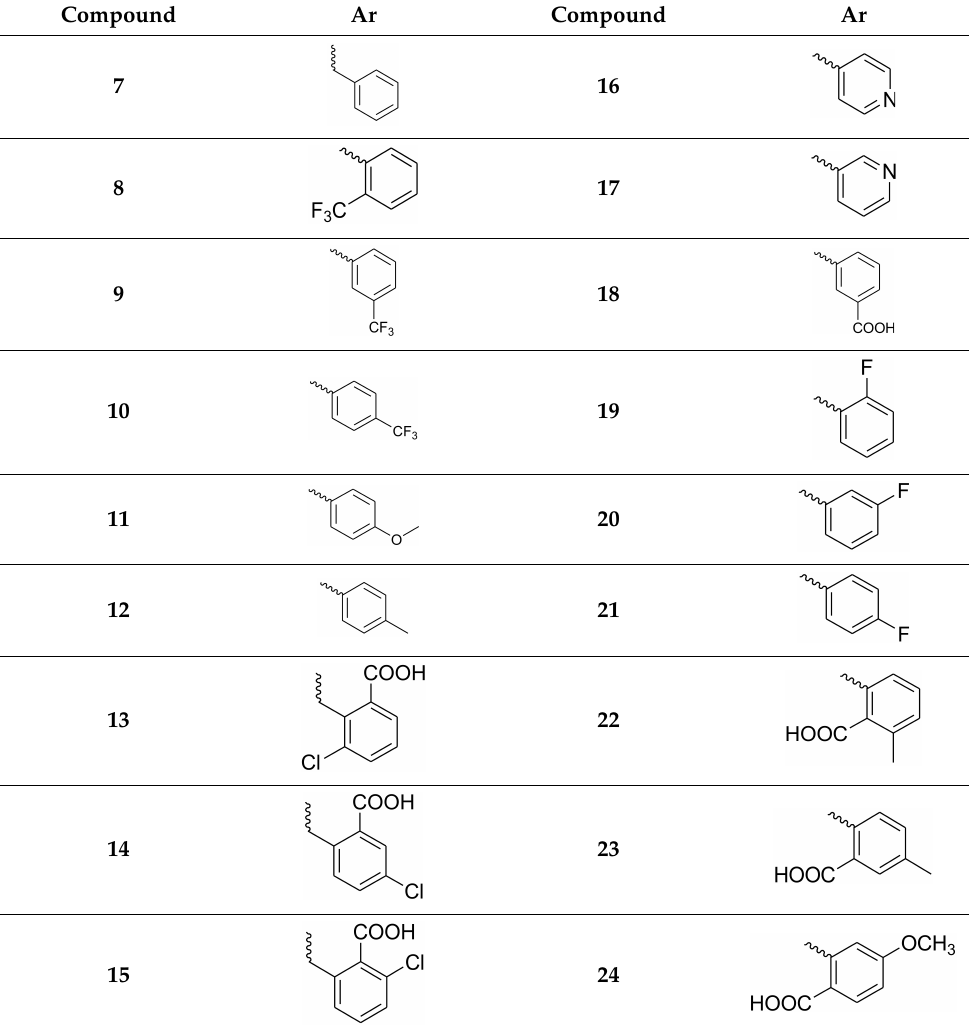
Table 1. Structures of synthesized derivatives of N -phenyl-6-chloro-4-hydroxy- 2-quinolone- 3- carboxamide ( 7 – 24